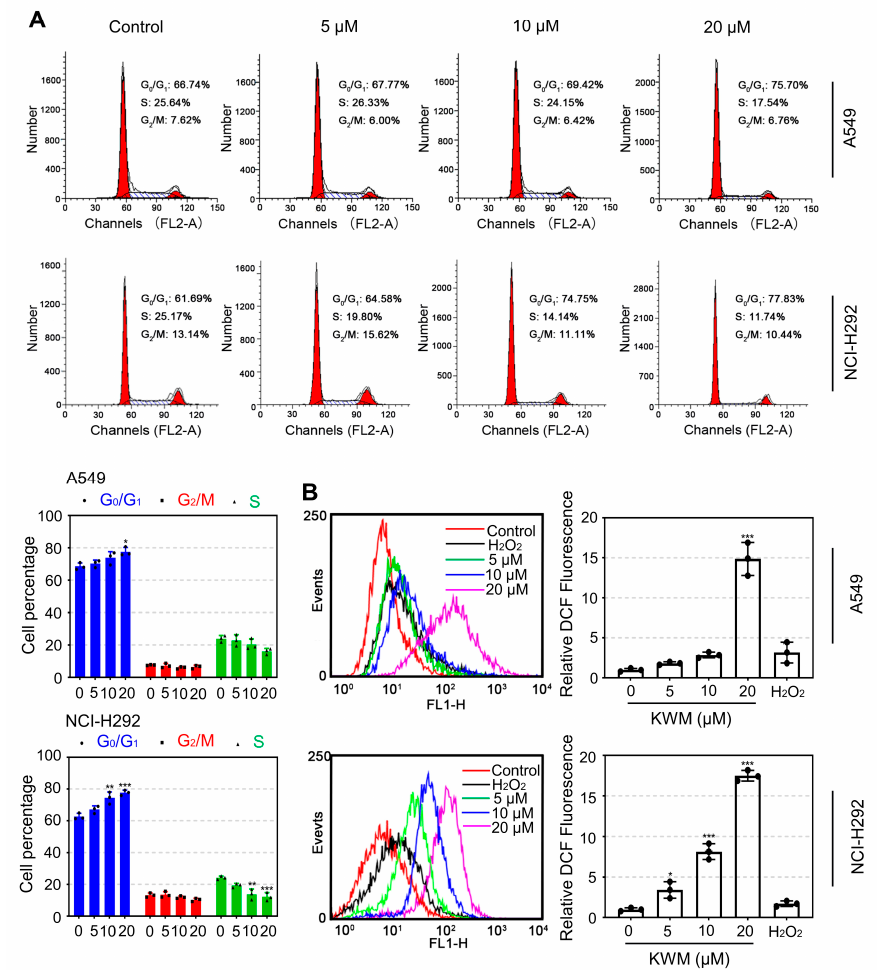
Figure 3. KWM-induced cell cycle arrest and accumulation of ROS in A549 and NCI-H292 cells. ( A ) A549 and NCI-H292 cells were treated with the indicated doses of KWM for 24 h, and PI staining and flow cytometry analysis were used to illustrate the distribution of each phase. ( B ) Cells were treated with KWM for 24 h. The fluorescence obtained by the oxidation of DCFH–DA was determined by flow cytometry. H 2 O 2 treatment was used as a positive control. The relative fluorescence intensity was presented as mean ± SD of three independent experiments. * p < 0.05, ** p < 0.01, and *** p < 0.001 versus control groups.